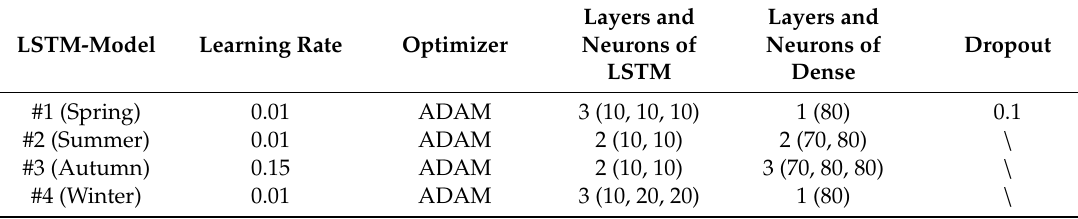
Table 3. Parameters used for the LSTM in each season.